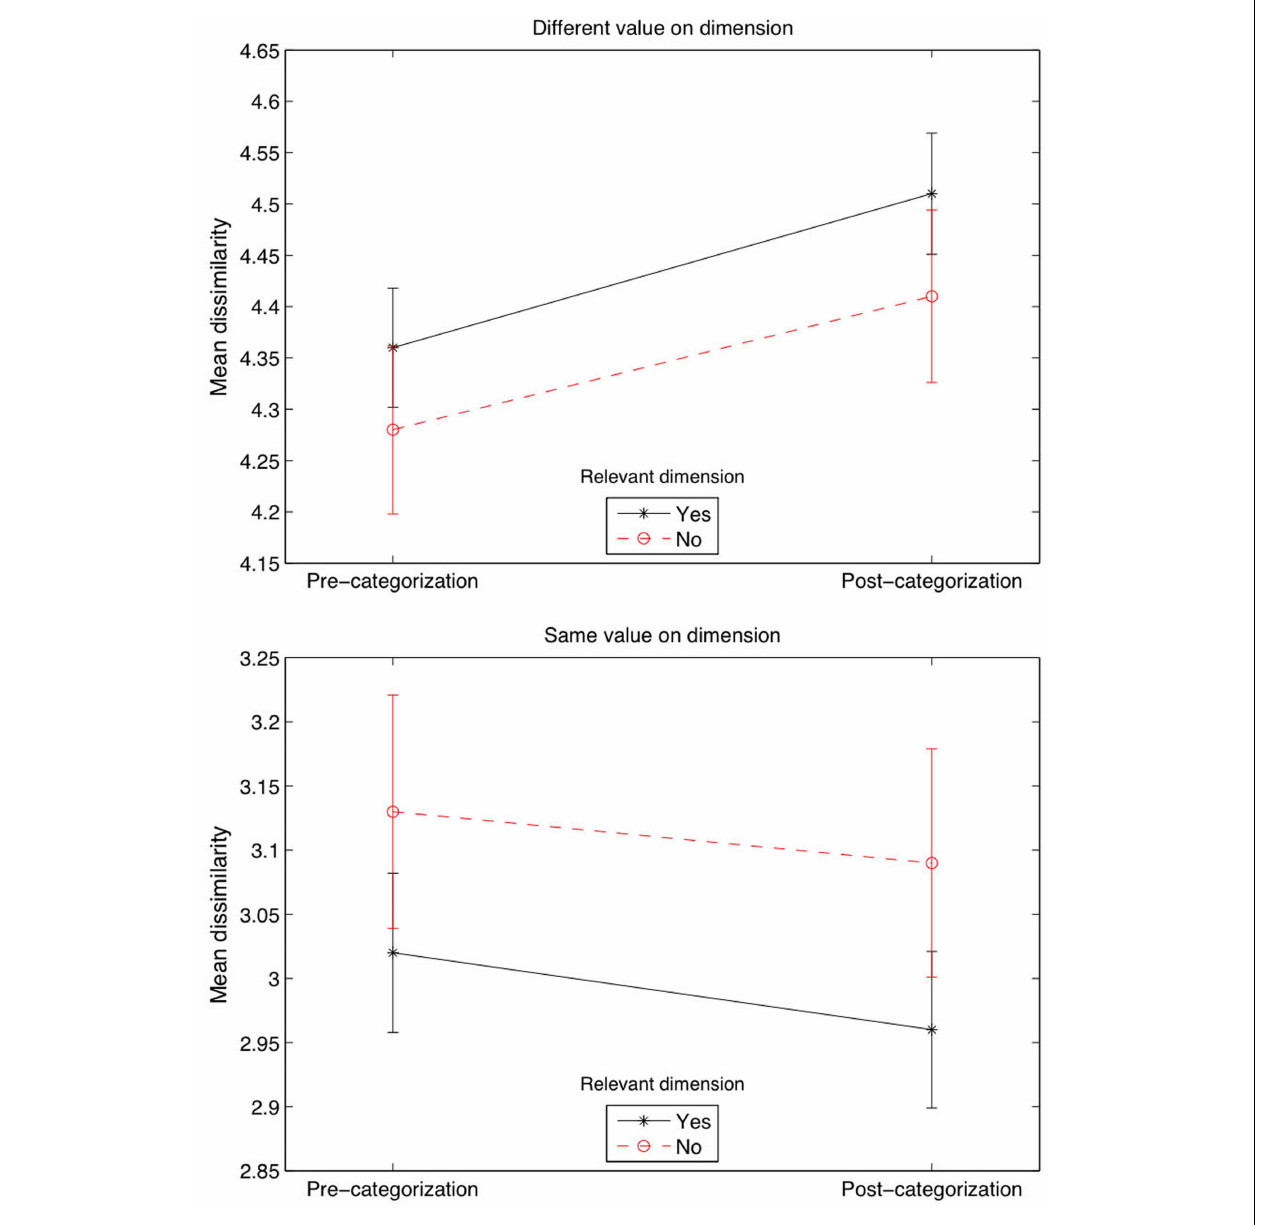
factors. The analysis showed a significant effect of same Dimen- was relevant during the categorization phase (first plot, top right sion Value [ F (1,9064) = 637, p < 0.001] and a Relevant × same value), whereas the dissimilarity rating was lower when two Dimension Value interaction [ F (1,9064) = 4.1, p < 0.05]. We also stimuli had the same value on a relevant, compared to irrele- averaged the data and run a more appropriate three-way repeated vant, dimension (second plot, bottom right value). This indicates ANOVA, which showed a significant effect of same Dimension that the greatest divergence in similarity ratings occurred for = 0.85] and, in this condi- Value [ F (1,53) = 308, p < 0.001, η 2 the relevant dimensions, in line with previous research (Kurtz, p tion, a Phase × same Dimension Value interaction [ F (1,53) = 7.5, 1996; Livingston et al., 1998; Goldstone et al., 2001). Dissimi- = 0.12]. Figure 5 shows, for example, that the p = 0.009, η 2 larity was increased the most when objects differed on dimen- p dissimilarity rating when two stimuli did not have the same sions that were categorization-relevant rather than categorization- value on one dimension was the highest when the dimension irrelevant. Likewise, similarity was increased the most